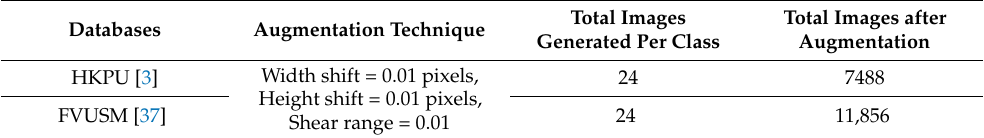
Table 4. Augmentation Details about the Publicly Available Finger Vein Image Databases used in this